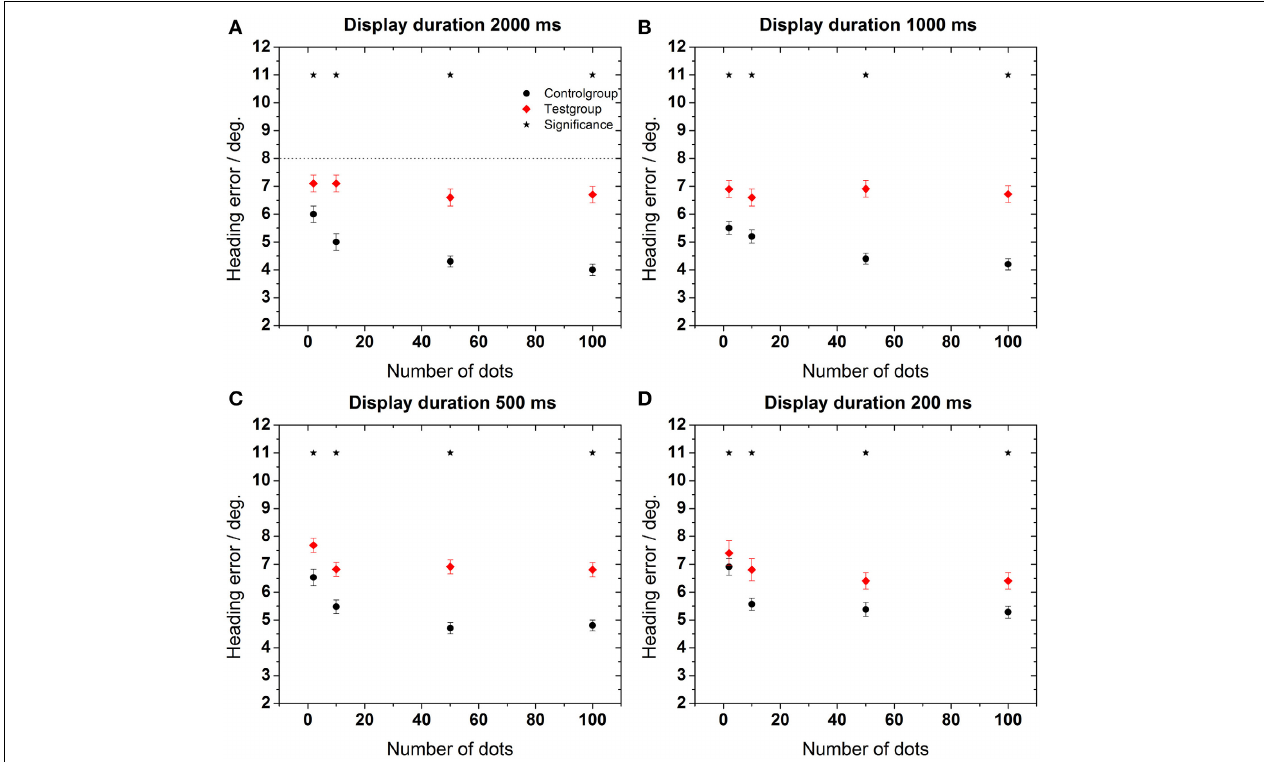
FIGURE 4 | Heading error as function of the number of dots in the display. Data in each panel were obtained for a specific stimulus duration as indicated on top of each panel (A–D) . Error bars show standard error. Asterisks indicate significant differences between data from the control and